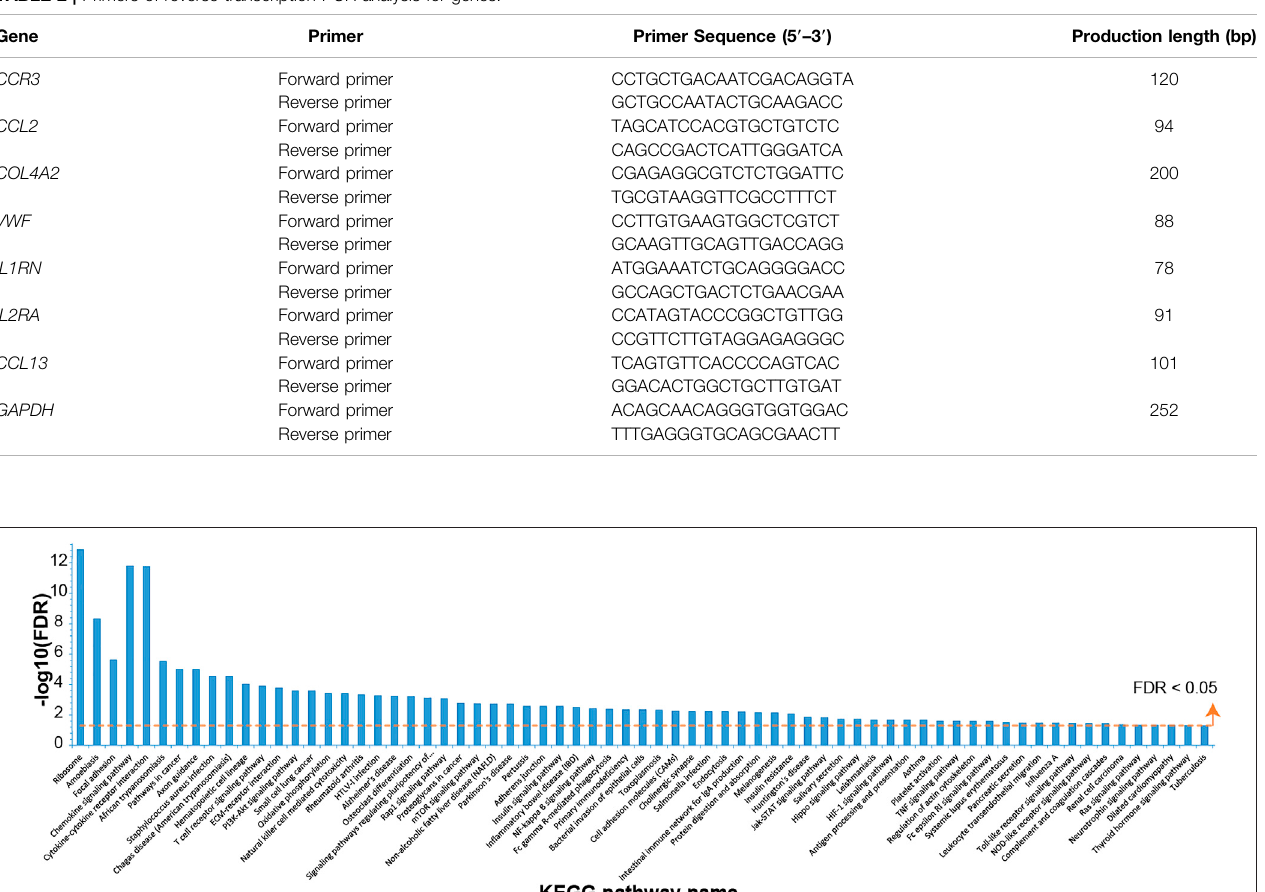
TABLE 2 | Primers of reverse transcription PCR analysis for genes.